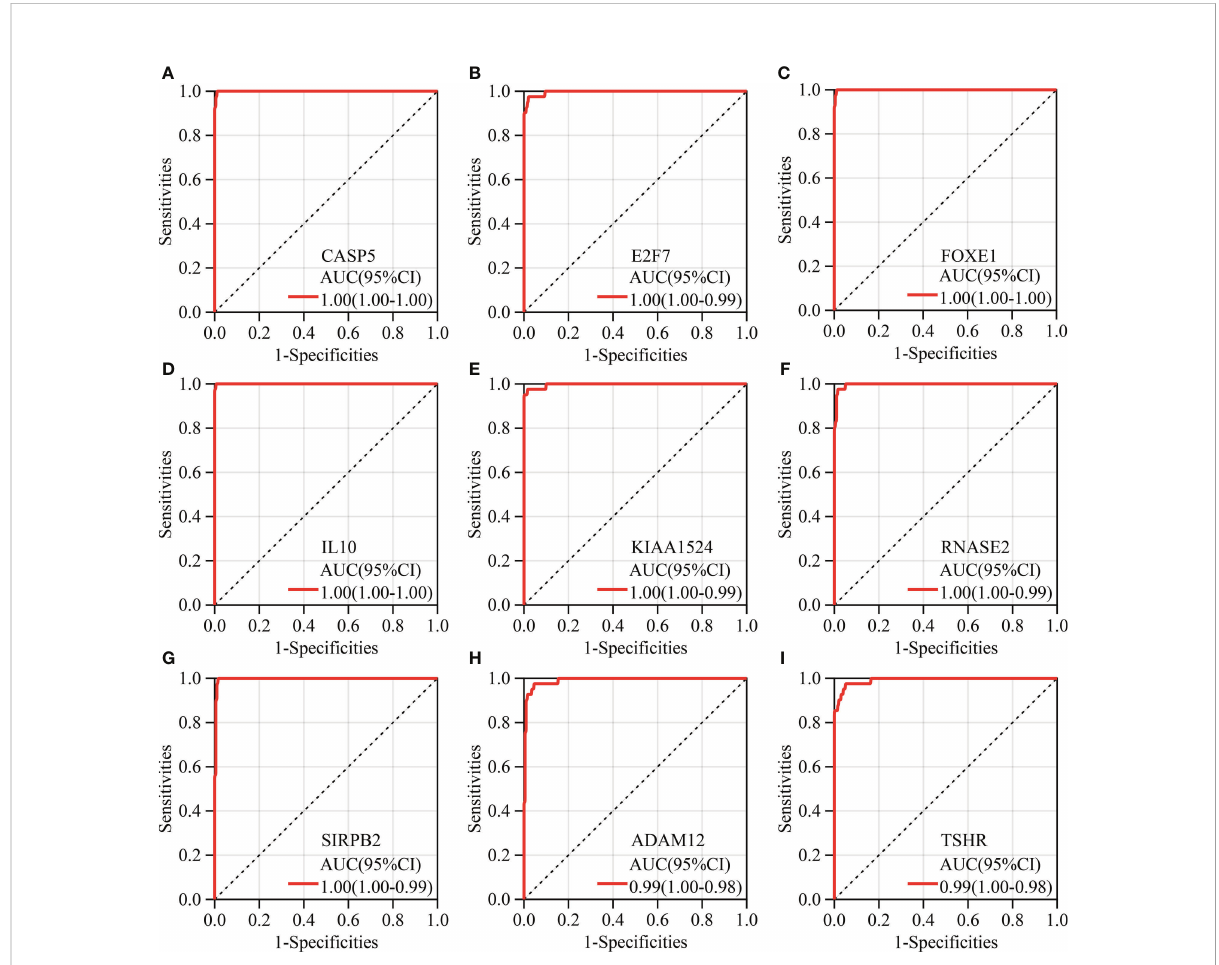
FIGURE 4 Diagnostic ROC analysis of hub genes. (A – I) The top nine key genes with the largest AUC of